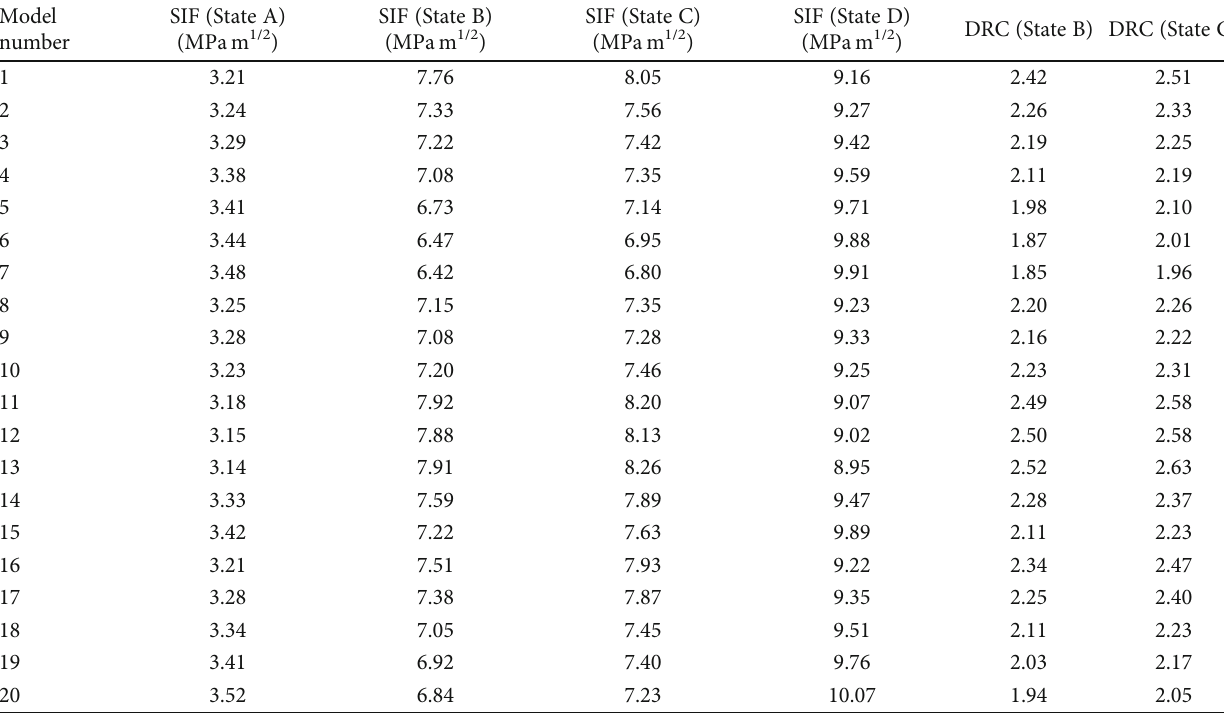
Table 6: DRC calculation results and dynamic initiation SIFs (DISs) of crack tip.